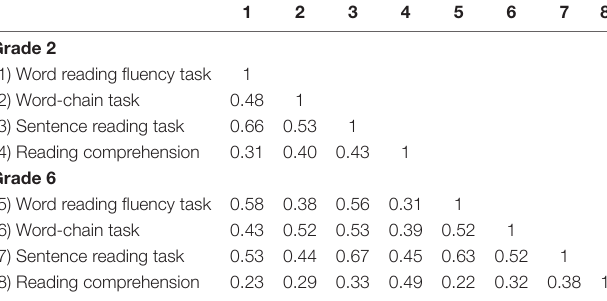
TABLE 2 | Correlations between reading fluency and reading comprehension